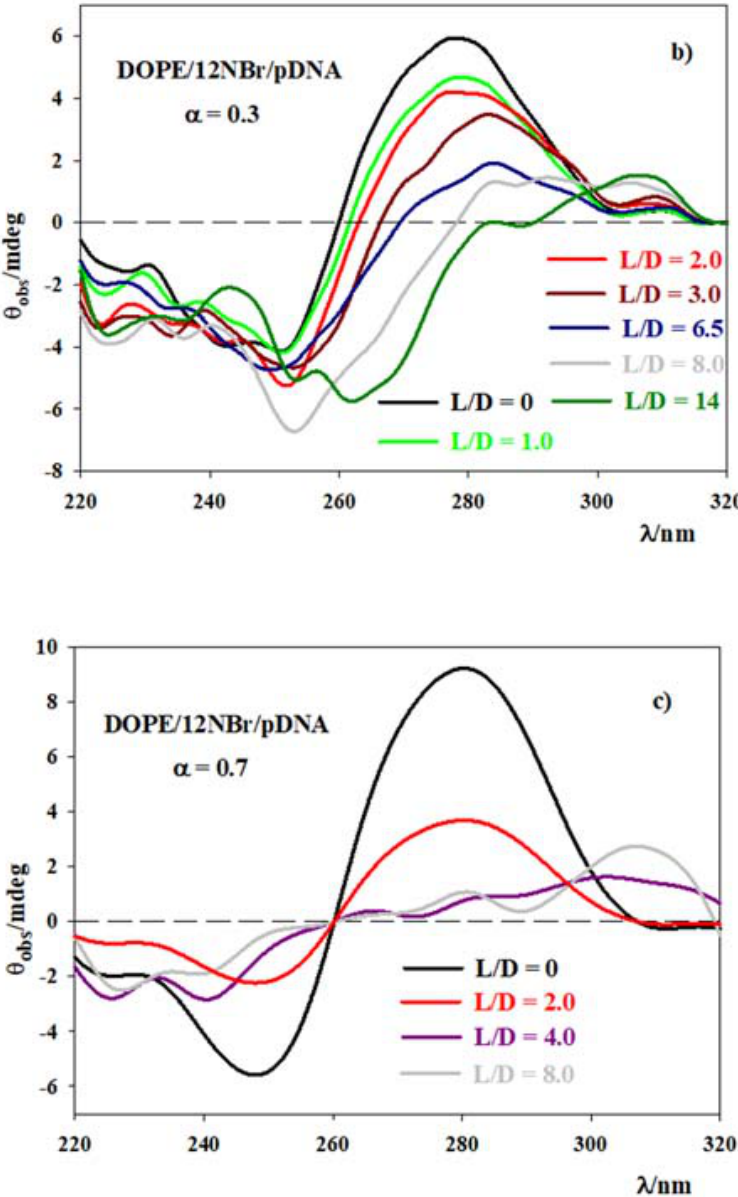
Figure 7. Dependence of the circular dichroism spectra of pDNA (3.0 × 10 − 5 M) in the DOPE/12NBr/pDNA lipoplexes, for various α values, on the ratio L/D. The experimental values are expressed as the mean ± SD ( n = 9). Experimental conditions: [pDNA] = 3.0 × 10 − 5 M, HEPES 10 mM (pH = 7.4) and T = 303.0 ± 0.1 K. ( a ) α = 0.2, ( b ) α = 0.3 and ( c ) α = 0.7